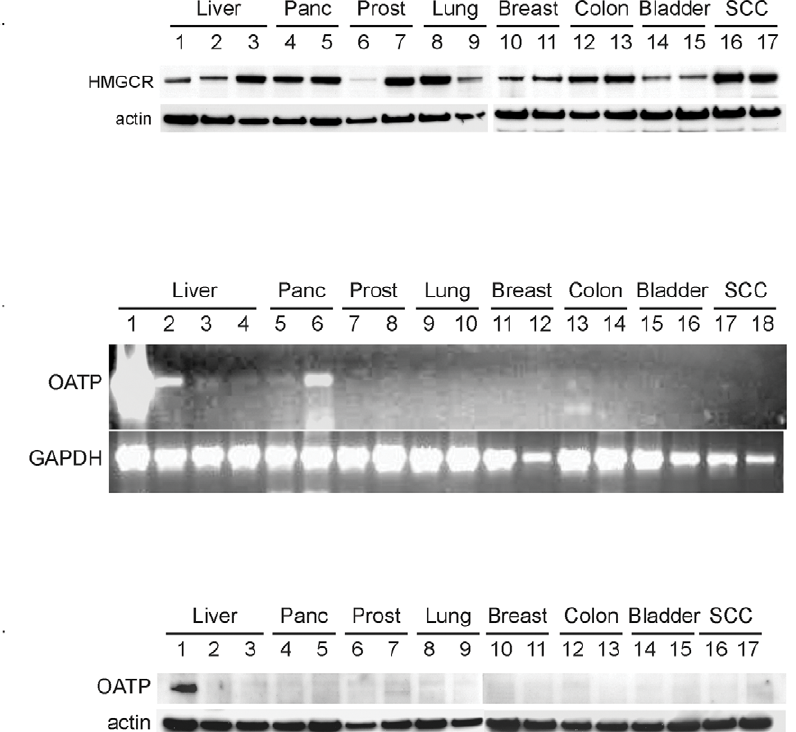
Figure 4. 3-hydroxy-3-methylglutaryl coenzyme A reductase (HMGCR) expression varies between cells but the organic anion transporter (OATP) is expressed exclusively in normal liver. A) HMGCR was examined by Western analysis for its expression as follows: liver (normal hepatocytes, lane 1; HepG2, lane 2; Hep3B, lane 3), pancreas (Capan 1, lane 4; Mia Paca, lane 5), prostate (LnCap, lane 6; PC-3, lane 7), lung (Calu3, lane 8; Calu6, lane 9), breast (MCF-7, lane 10; SkBr3, lane 11), colon (Cacao 2, lane 12; HCT116, lane 13), bladder (U9, lane 14; U14, lane 15), or squamous cell carcinoma (SCCP9, lane 16; SCCM7, lane 17). These data illustrate that HMGCR expression does not correspond to drug response. B) Total RNA isolated from human liver tissue (lane L) or cells and analyzed for expression of a 565 bp amplimers from OATP. The numeric sequence of